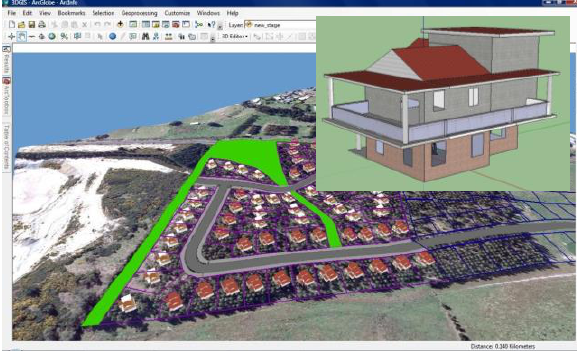
Figure 2. Process flow diagrams: (a) Whole development and assessment process for VE, CAD and GIS; (b) Processing for the GIS 3D model (c) Processing in GIS and image processing environments for VE content